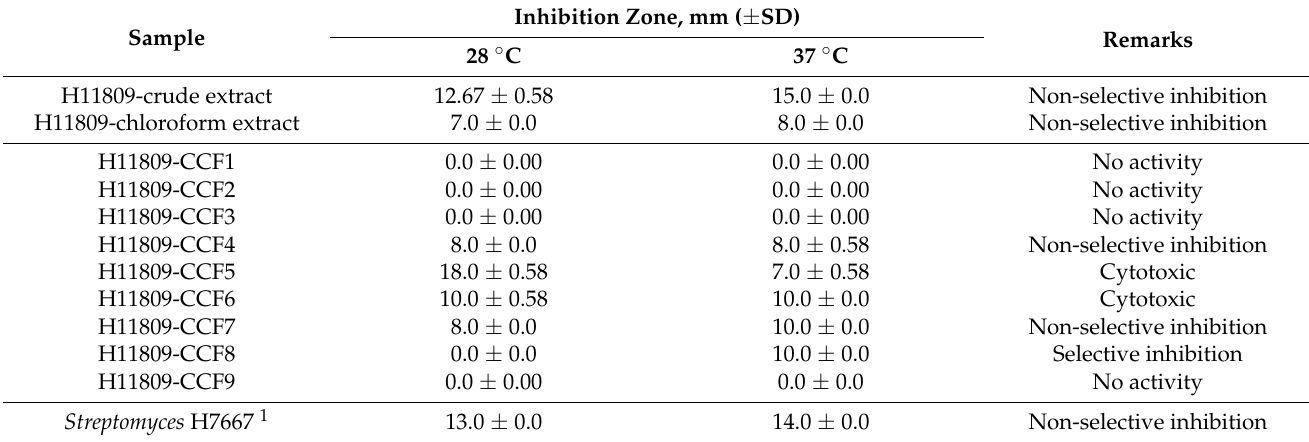
Table 1 . The inhibitory activity of different fractionation stages of H11809. Column chromatography fraction of H11809-chloroform extract; H11809-CCF8 showed the most significant GSK-3 β inhibi- tory activity.